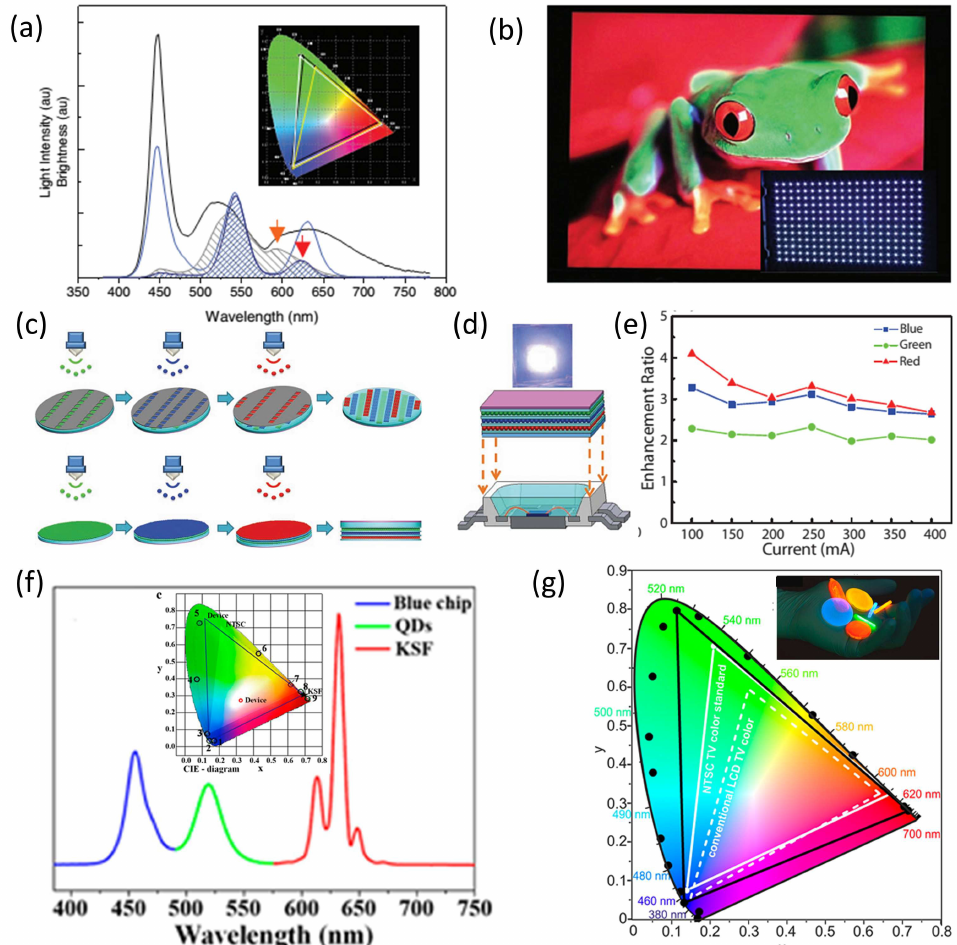
Figure 3: (a) Spectrum of the white light-emitting diode (LED) fabricated using quantum dot (QD) films on a blue LED chip along with the Na- tional Television Standards Committee (NTSC) color gamut (inset, yellow triangle) and the color gamut of the produced white LED (inset, white triangle). (b) Display image of 46 inches display. Reproduced with permission from Ref. [85], Copyright Wiley International. (c)